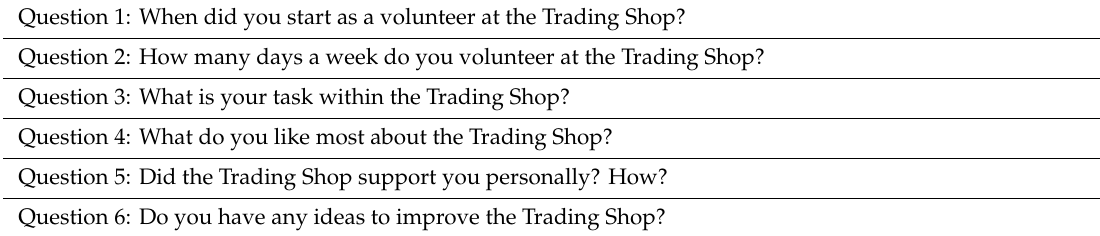
Table 3. Interview guide volunteers.